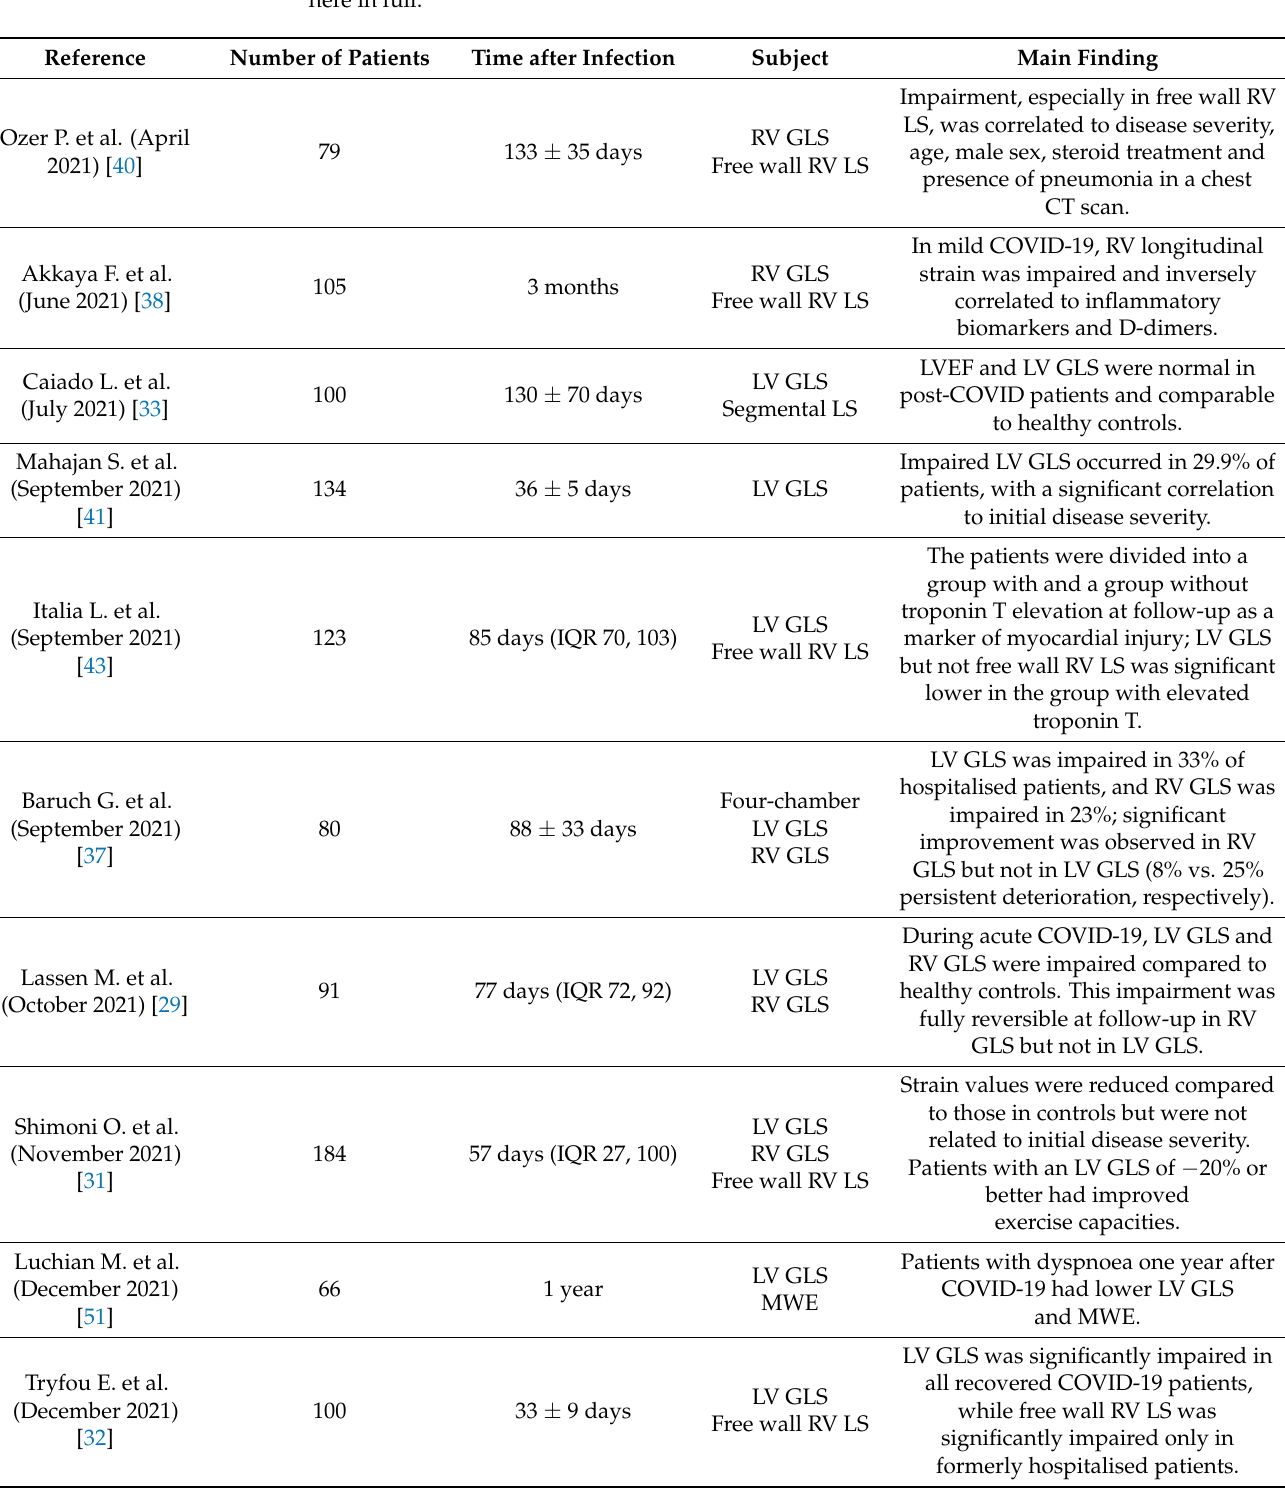
Table 2. Studies using speckle-tracking echocardiography with a focus on post-COVID. Note that the cohorts are very heterogeneous due to the individual inclusion criteria. This could not be presented here in